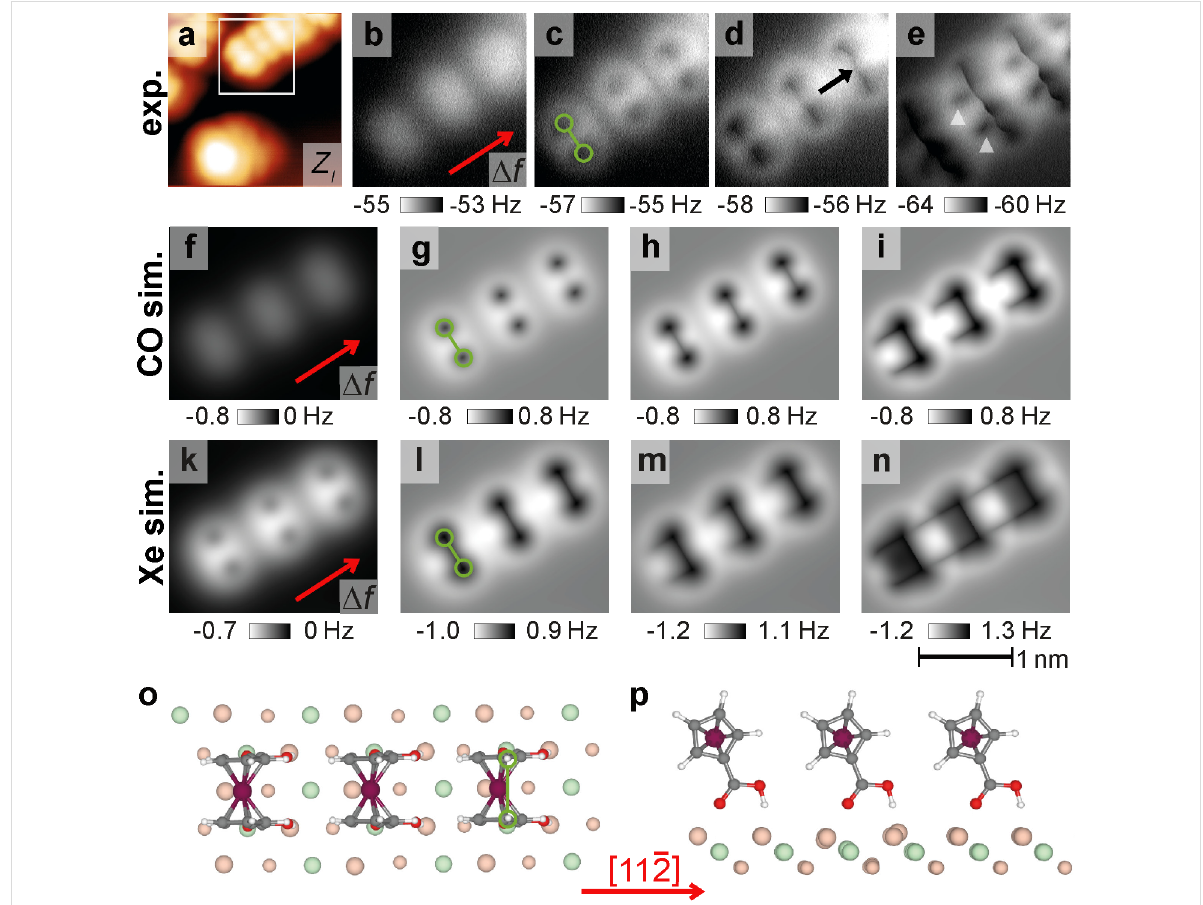
Figure 2: High-resolution NC-AFM imaging and simulation. Experimental and simulated frequency-shift images of a single molecular row along the direction (red arrows). Exemplary molecules are marked by a green dumbbell. (a) Experimental STM image ( U = 4 V, I t = 2 pA). (b–e) Experi- mental constant-height NC-AFM data ( f 0 = 24363 Hz, Q 0 ≈ 6000, A 0 = 0.27 nm). Frequency shift ranges are shown below each image (inverted colour scales are used). A four pixel averaging filter was applied to reduce noise within the frequency shift images. A slight tilt of the constant-height plane leads to a small modulation along the row. (f–i) Simulated NC-AFM images using a CO tip model. (k–n) Simulated NC-AFM images for a Xe tip model positioned with the tip backbone positioned at the same heights as for the CO image calculations. (o, p) Structure of the simulation cell with each mol- ecule in the single-molecule DFT-optimised geometry geo 1